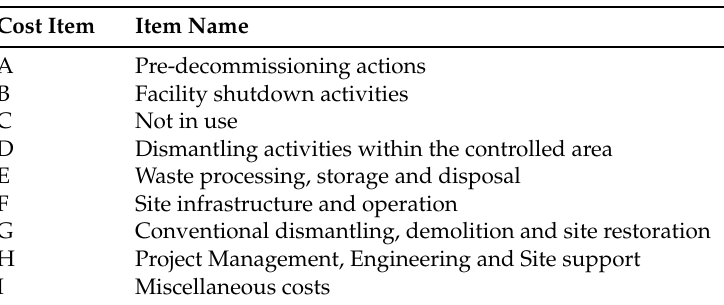
Table 2. Overall Cost Breakdown